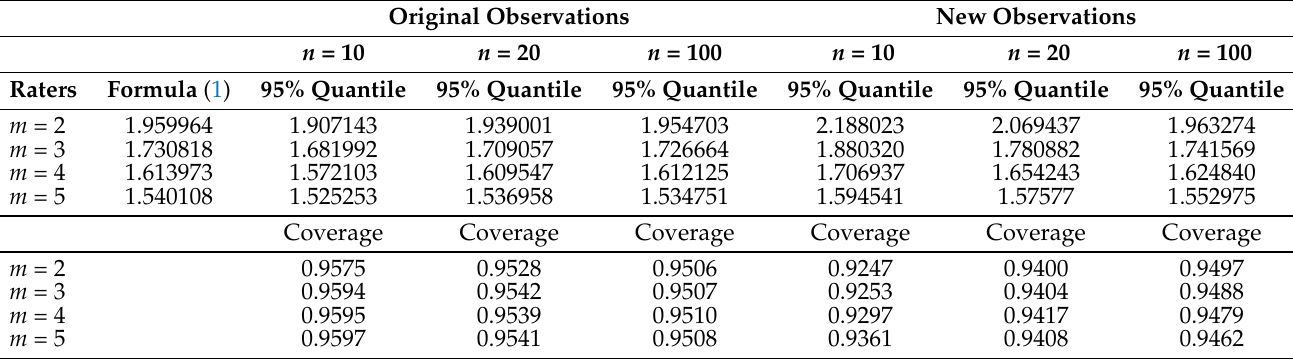
Table 1. Coverage and empirical 95% quantiles from the simulations of different choices of m and n . Results are reported both for the original observations used to estimate the LOA, as well as for the new observations obtained from the same data generating